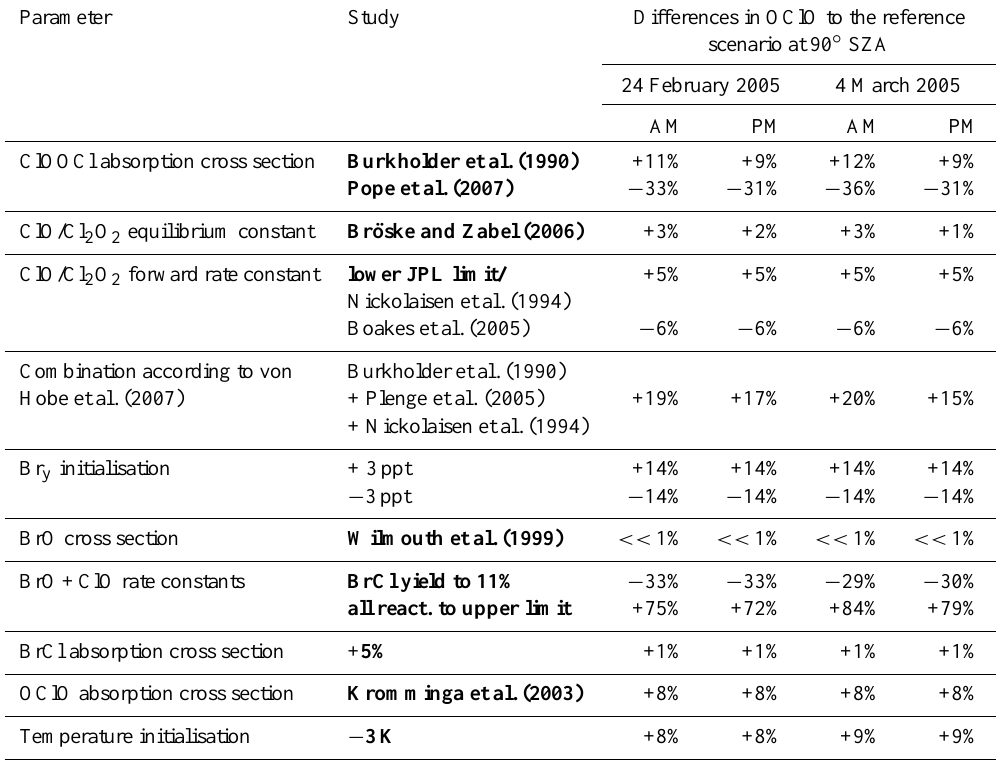
Table 1. Summary of the sensitivity studies of the box model in comparison to the JPL 2002 simulation at a SZA of 90 ◦ . Texts in bold characters represent scenarios visualised in Fig. 8. More details can be found in the Sect. 6. Parameter